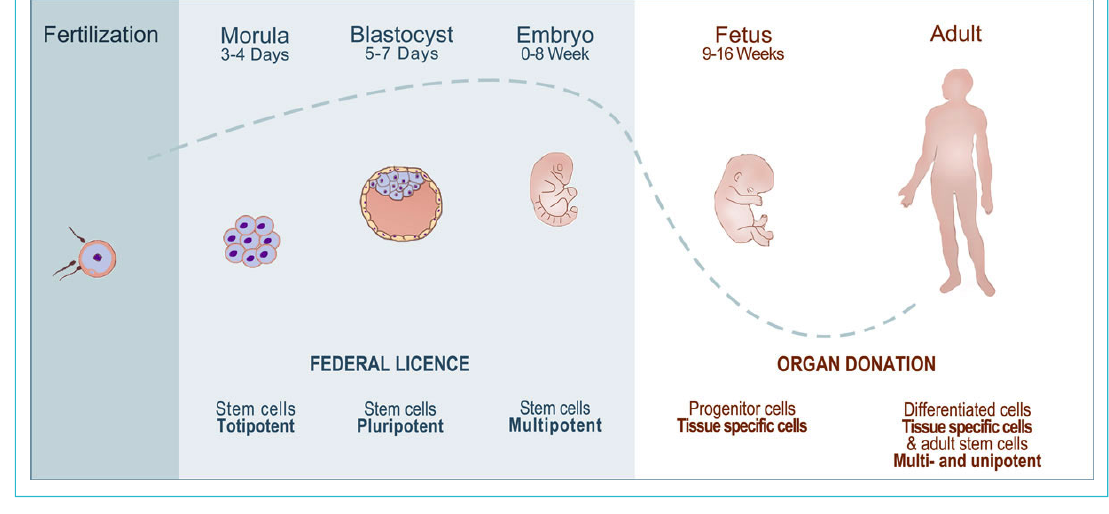
Figure 2: Different stages of development. In Switzerland, the use of human fetal cells and adult cells is part of a Federal Transplantation Pro- gramme (blue), whereas the use of human cells at earliest stage requires a license (red).